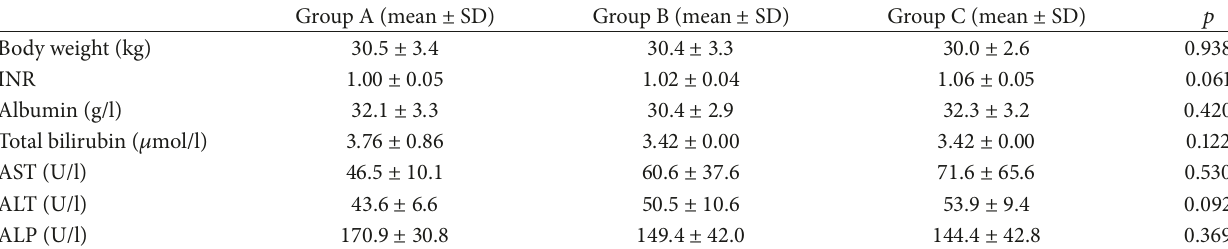
Table 1: Body weight and laboratory results before liver resection.